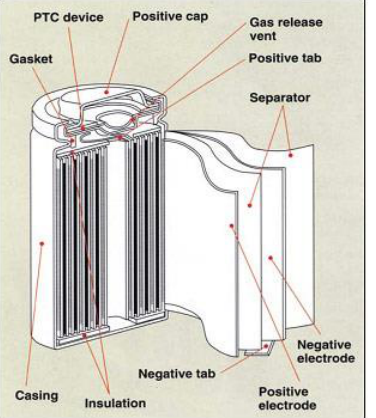
Figure 1. Cross-section of a lithium-ion battery cylindrical cell.